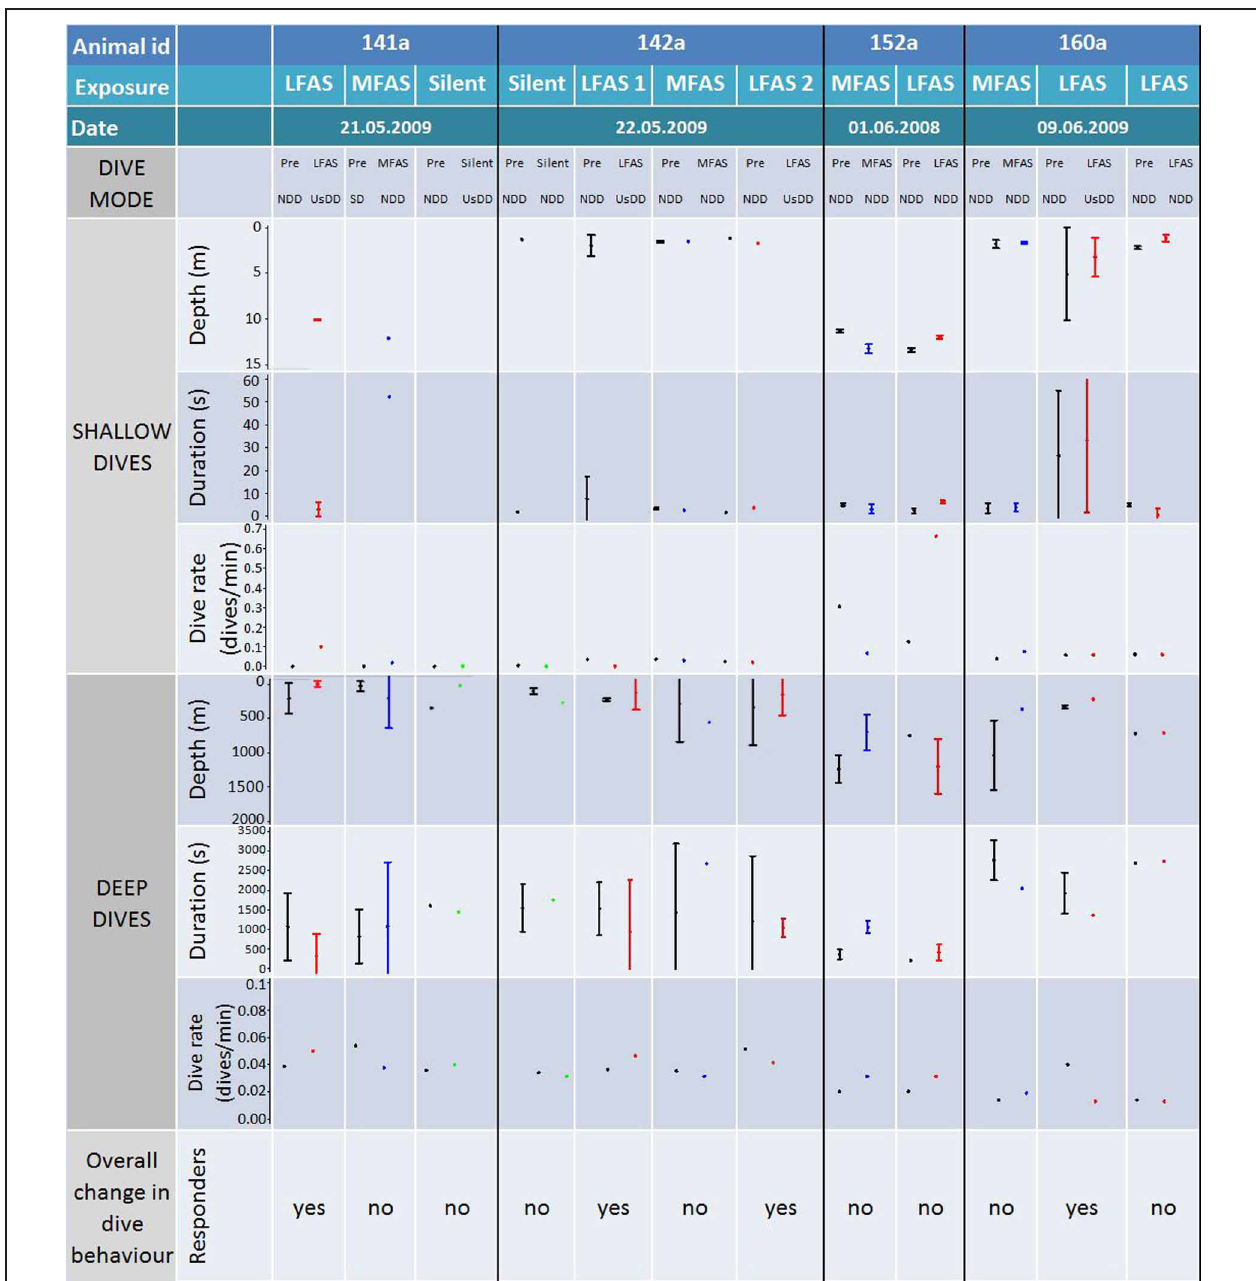
FIGURE 7 | Comparison of individual exposures to sperm whales. Figure shows animal id, exposure type, dive mode (during PRE and Exposure), as well as dive depth, duration, and rate for both shallow and deep dives. Log frequency analysis defined deep and shallow dives to be deeper and shallower than 13m respectively for killer whales. Codes for dive modes are: shallow diving (ShD), normal deep diving (NDD), and unusual shallow deep